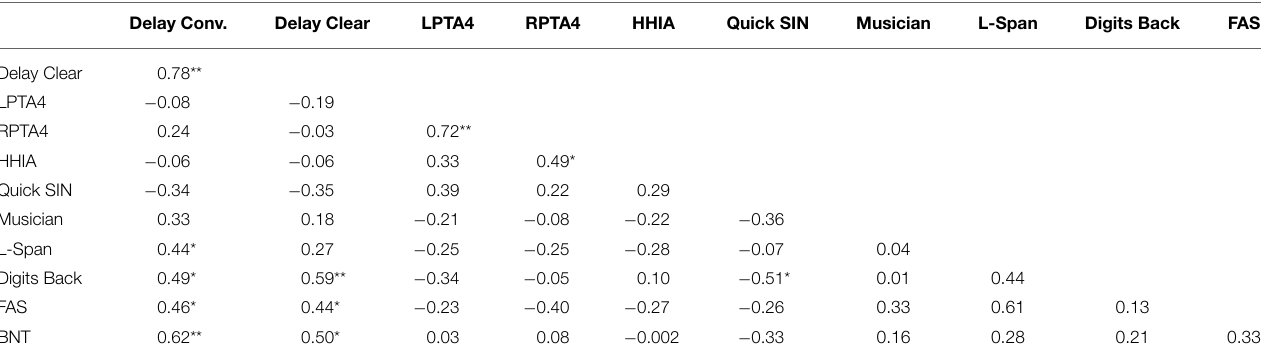
TABLE 10 | Correlation analysis between delayed memory performance in the conversational (conv.) and clear listening conditions and hearing and cognitive abilities–Noise group. Delay